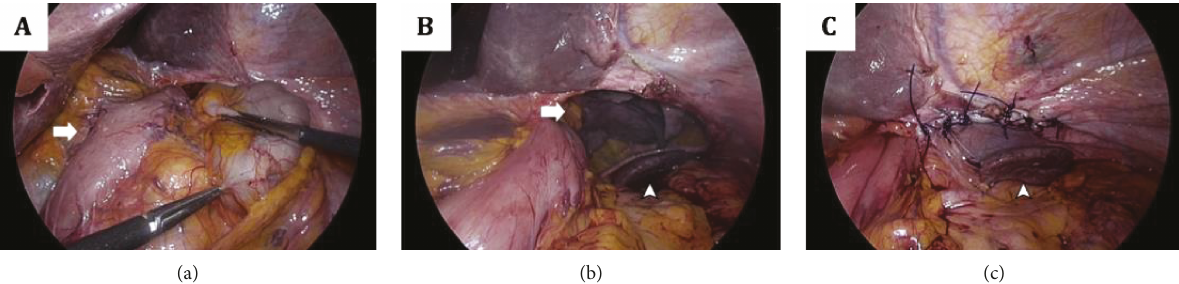
Figure 2: Intraoperative view of the diaphragmatic hernia. (a) The gastric conduit is visible to the right of the herniated viscera (arrow); (b) after the reduction of the hernia content, the diaphragmatic defect, the left lung (arrow), and the spleen (arrowhead) are clearly visible; (c) the diaphragmatic defect repaired by direct